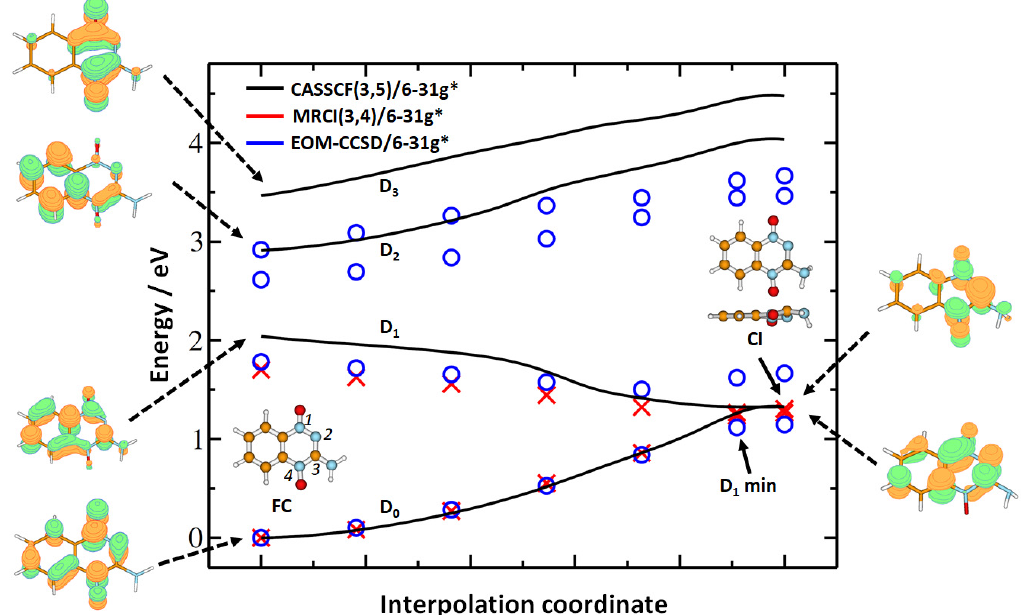
Figure 1. Interpolation from the Franck–Condon point (FC) to the minimum on the D 1 electronic state potential energy surface in TPZ − and further to the D 0 /D 1 conical intersection (CI). The FC point was optimized at the B3LYP/aug–cc–pVDZ level of theory, D 1 minimum and CI at the complete active space–self consistent field (CASSCF)(3,5)/6–31g* level. The interpolation points were recalculated at the multireference configuration interaction (MRCI)(3,4) and equation of motion-coupled clusters singles and doubles (EOM-CCSD) level with the 6–31g* basis set. For the CI, both top and side view is provided to show the triazine ring distortion. On the left-hand and right-hand sides, singly occupied orbitals, according to the configuration with the highest contribution to the respective electronic state in the configuration interaction vector, are shown as calculated in the FC point and CI at the CASSCF level.